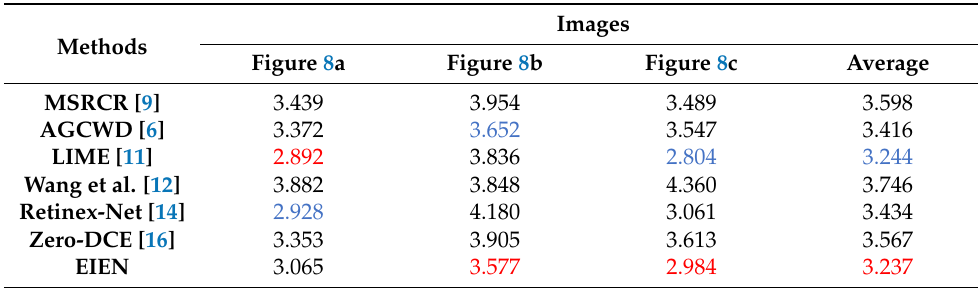
Table 1. NIQE results for different algorithms. The best result is in red whereas the second best one is in blue.